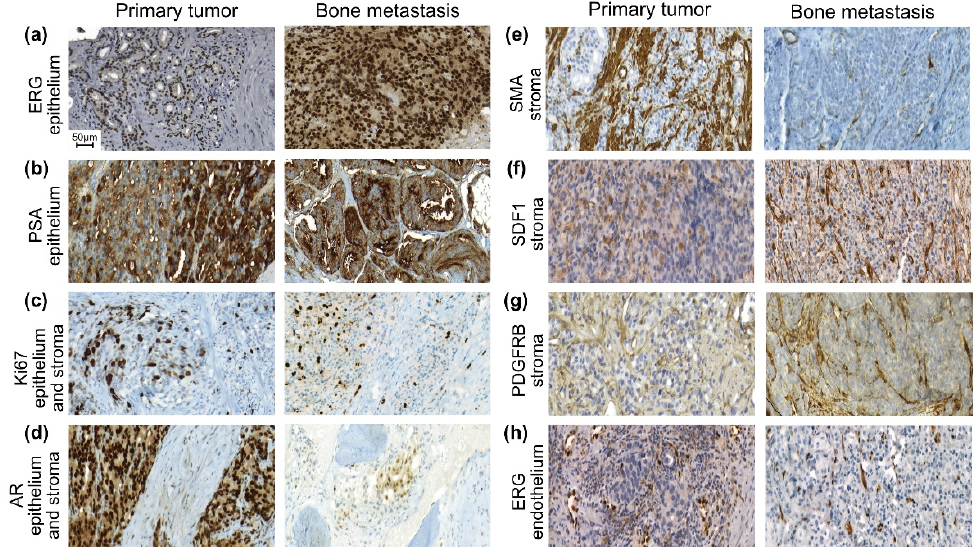
Figure 1. Sections from paired primary prostate tumors and bone metastases immune stained for ETS ‐ related gene (ERG) ( a , h ), prostate specific antigen (PSA) ( b ), the marker for proliferation Ki67 ( c ), androgen receptor (AR) ( d ), smooth muscle actin (SMA) ( e ), stroma derived factor 1 (SDF1) ( f ), and platelet ‐ derived growth factor receptor β (PDGFRB) ( g ), all seen at the same magnification (see scalebar in a). ( a ) ERG positive tumor cells in a primary tumor and in the paired metastasis. ( b ) Moderate (left side) to high (right side with glands) PSA staining in a primary tumor. Moderate PSA staining and glandular differentiation was seen in the metastasis (classified as MetA). ( c ) Sections with relatively high Ki67 labeling in epithelium and stroma in a primary tumor and in the paired bone metastasis. ( d ) AR positive epithelial and stroma cells were seen in the primary tumor. In the metastasis (classified as MetA), a nest of AR positive tumor cells was growing in a bone marrow space and a few AR positive cells are seen on the bone surface. ( e ) Numerous SMA positive smooth muscle cells are seen in the primary tumor, whereas only few cells were SMA positive in the paired bone metastasis (here only in blood vessel walls). This metastasis, lacking bone structures, was classified as MetB. ( f ) SDF ‐ 1 positive cells were seen in the stroma in the primary tumor, mainly in blood vessel walls. Such cells were also seen in the bone metastasis stroma. ( g ) PDGFRB positive stroma cells, mainly in blood vessel walls and in fibroblasts, were seen in the primary tumor stroma and in the paired metastasis (classified as MetB). ( h ) ERG positive endothelial cell nuclei were seen in the primary tumor and in its bone metastasis. Note that several tumor cells are lying close to endothelial cells. In this case, the tumor cells were ERG negative. This metastasis was classified as Ki67 high/PSA low but with unknown MetA ‐ C status. Blood vessels with ERG positive endothelial cells and walls positive for SMA, PDGFR ‐ beta, and SDF ‐ 1 were a dominant component of the bone metastasis stroma.